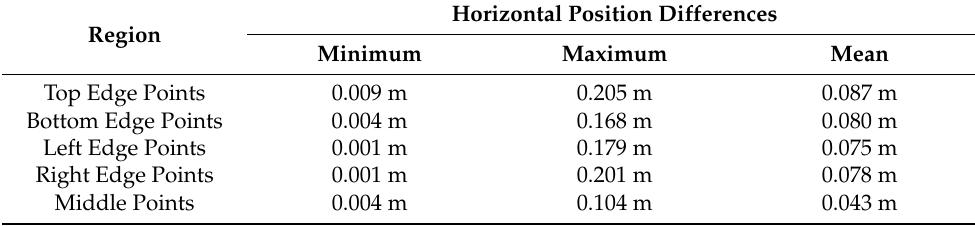
Table 8. Quantitative measures for the horizontal position differences of points within the five regions of interest for flight A after adjusting for the heading bias. Horizontal Position Differences Region Minimum Maximum Mean Top Edge Points 0.009 m 0.205 m 0.087 m Bottom Edge Points 0.004 m Right Edge